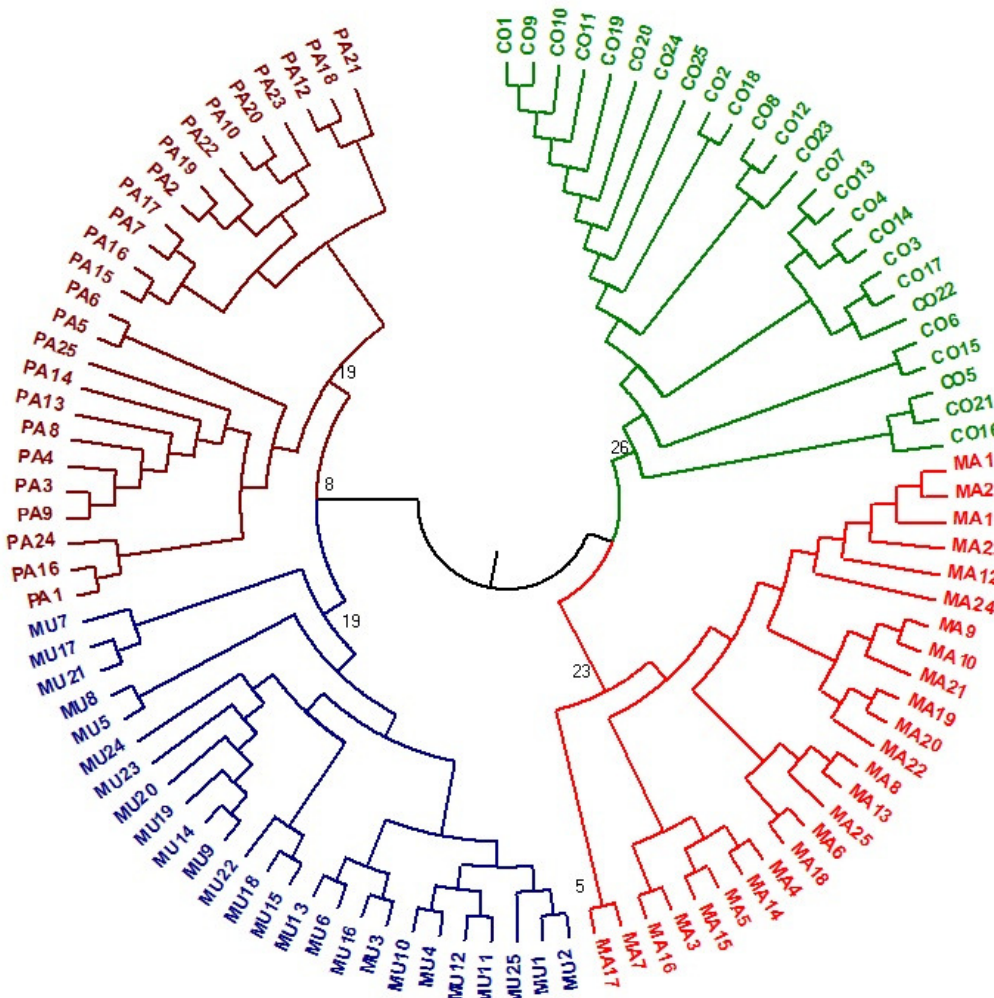
Fig. 4. Dendrogram Based Nei's Genetic distance (CO: Cochin; MA: Marakanam; MU: Muthupettai; PA: